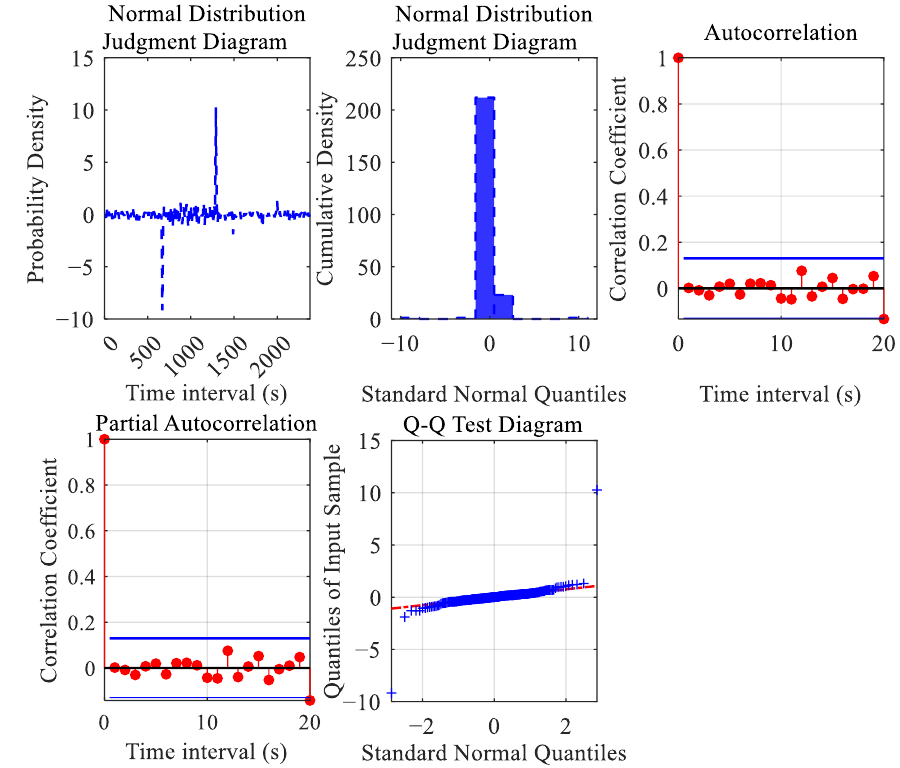
Figure 10. Visualization for the stability test of passenger flow leaving the station.